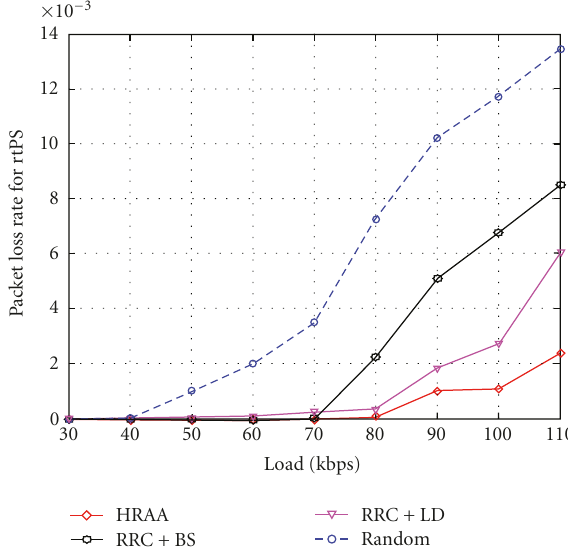
Figure 6: Delay comparison of ertPS SFs in inner cell versus load.